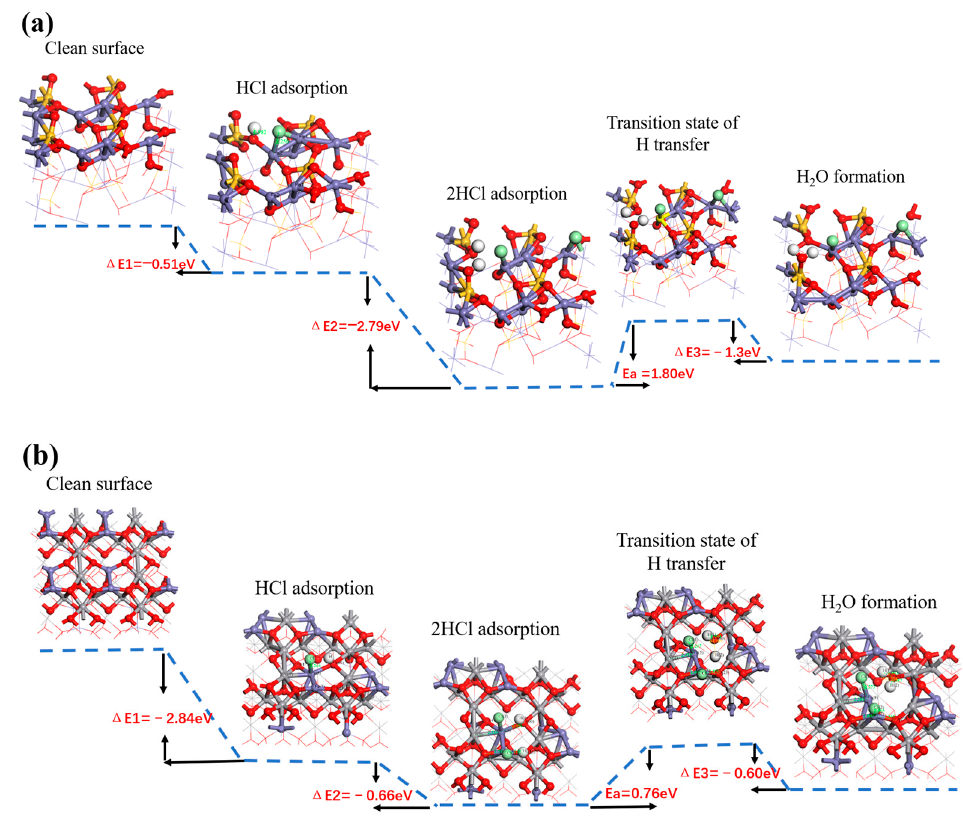
Figure 11. Energy path of chlorination of ( a ) Fe 2 SiO 4 and ( b ) FeV 2 O 4 by HCl.